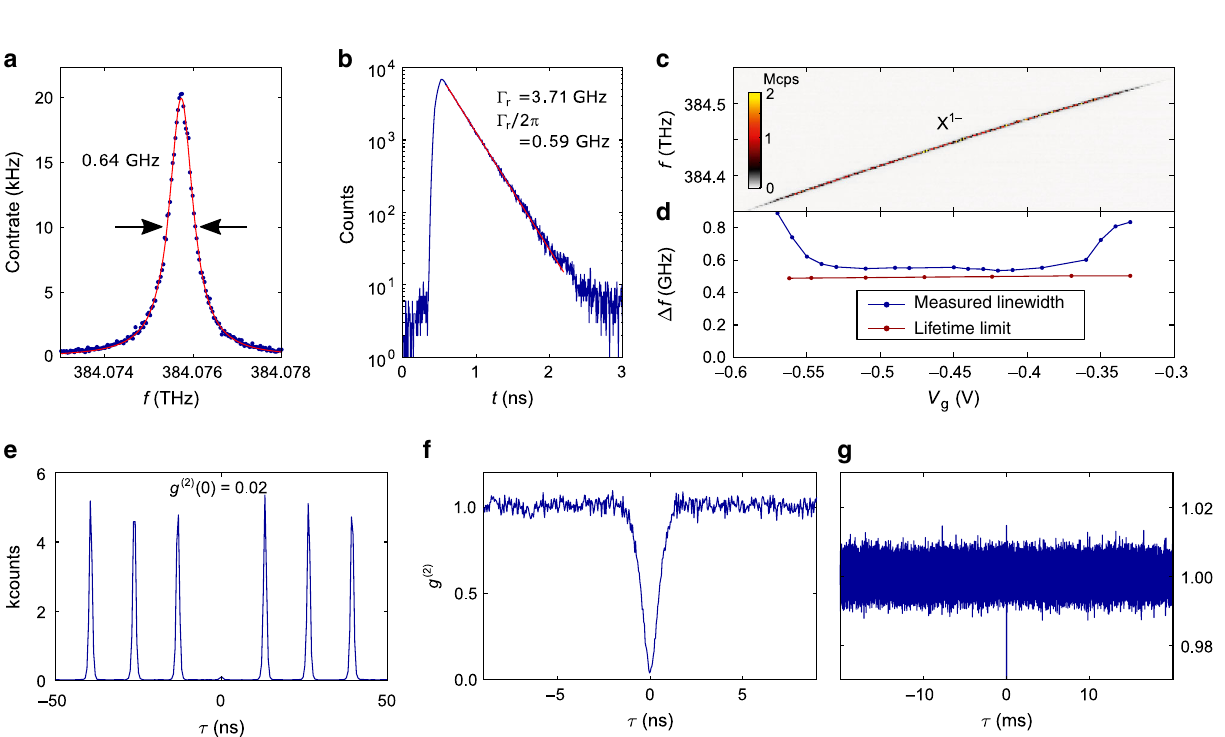
Fig. 2 Time-resolved lifetime and photon-correlation measurements. a Resonance fl uorescence linewidth measured on the singly-charged exciton, X 1 − (QD1). The measurement is performed by sweeping a narrow-bandwidth laser over the X 1 − resonance. The overall time for the shown scan is ~8 min. A Lorentzian function (red line) fi ts perfectly to the data (blue dots), showing an optical linewidth of 0.64 ± 0.01 GHz. b Lifetime measurement on X 1 − under pulsed resonant excitation. The gate voltage is the same as in a . The measured decay rate ( Γ r = 3.71 ± 0.04 GHz, corresponding to a lifetime of 1/ Γ r = 270± 3 ps) implies a lifetime-limited linewidth of Γ r /2 π = 0.59± 0.01 GHz (Exponential fi t). c Resonance fl uorescence of X 1 − (QD2) as a function of the gate voltage. d Resonance fl uorescence linewidth along with the lifetime-limit (obtained from separate lifetime measurements at the corresponding gate voltages). Similar to QD1, the linewidth of QD2 stays very close to the lifetime limit in the plateau centre. e Auto-correlation ( g (2) ) measured